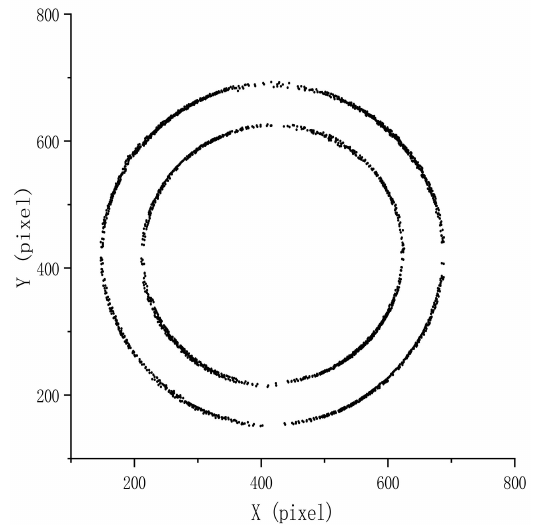
Figure 8. O-ring sub-pixel edge